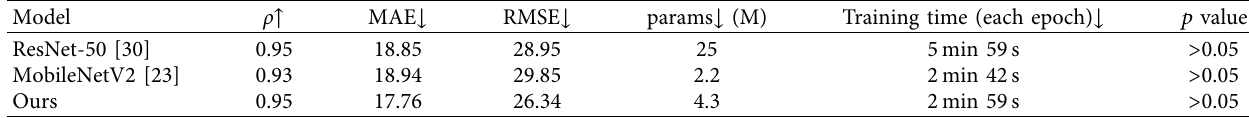
Table 4: Performance on our Sharp scoring dataset, comparison of different networks.